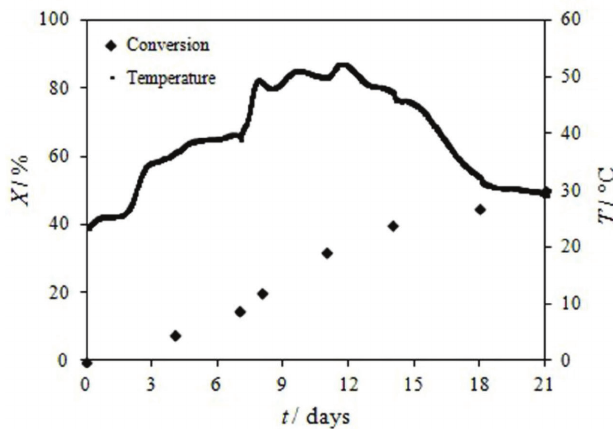
Fig. 4 – Changes in volatile solids mass in substrate during 21 days of composting process